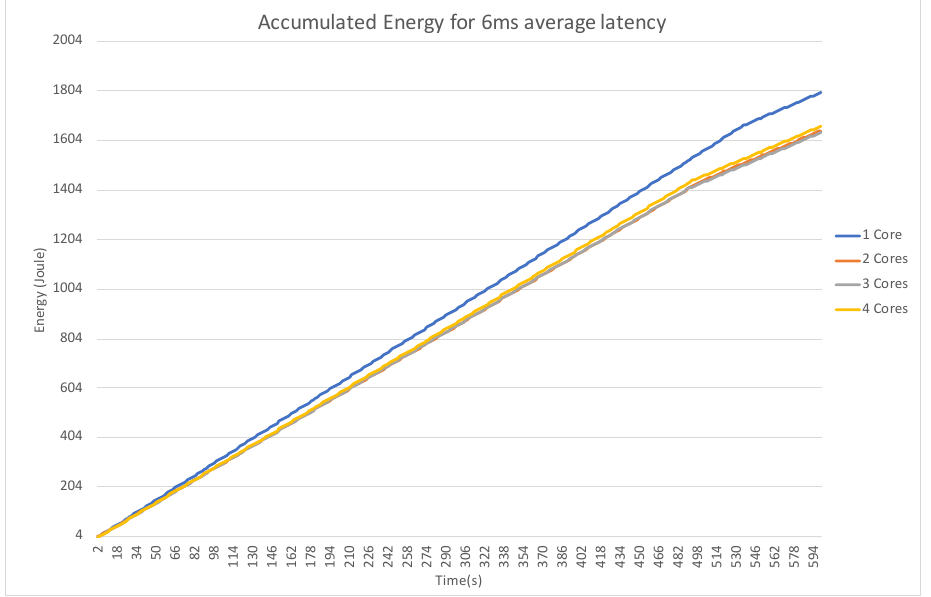
Figure 13. Accumulated energy consumption for different number of cores during network average latency test with 6 ms limit.